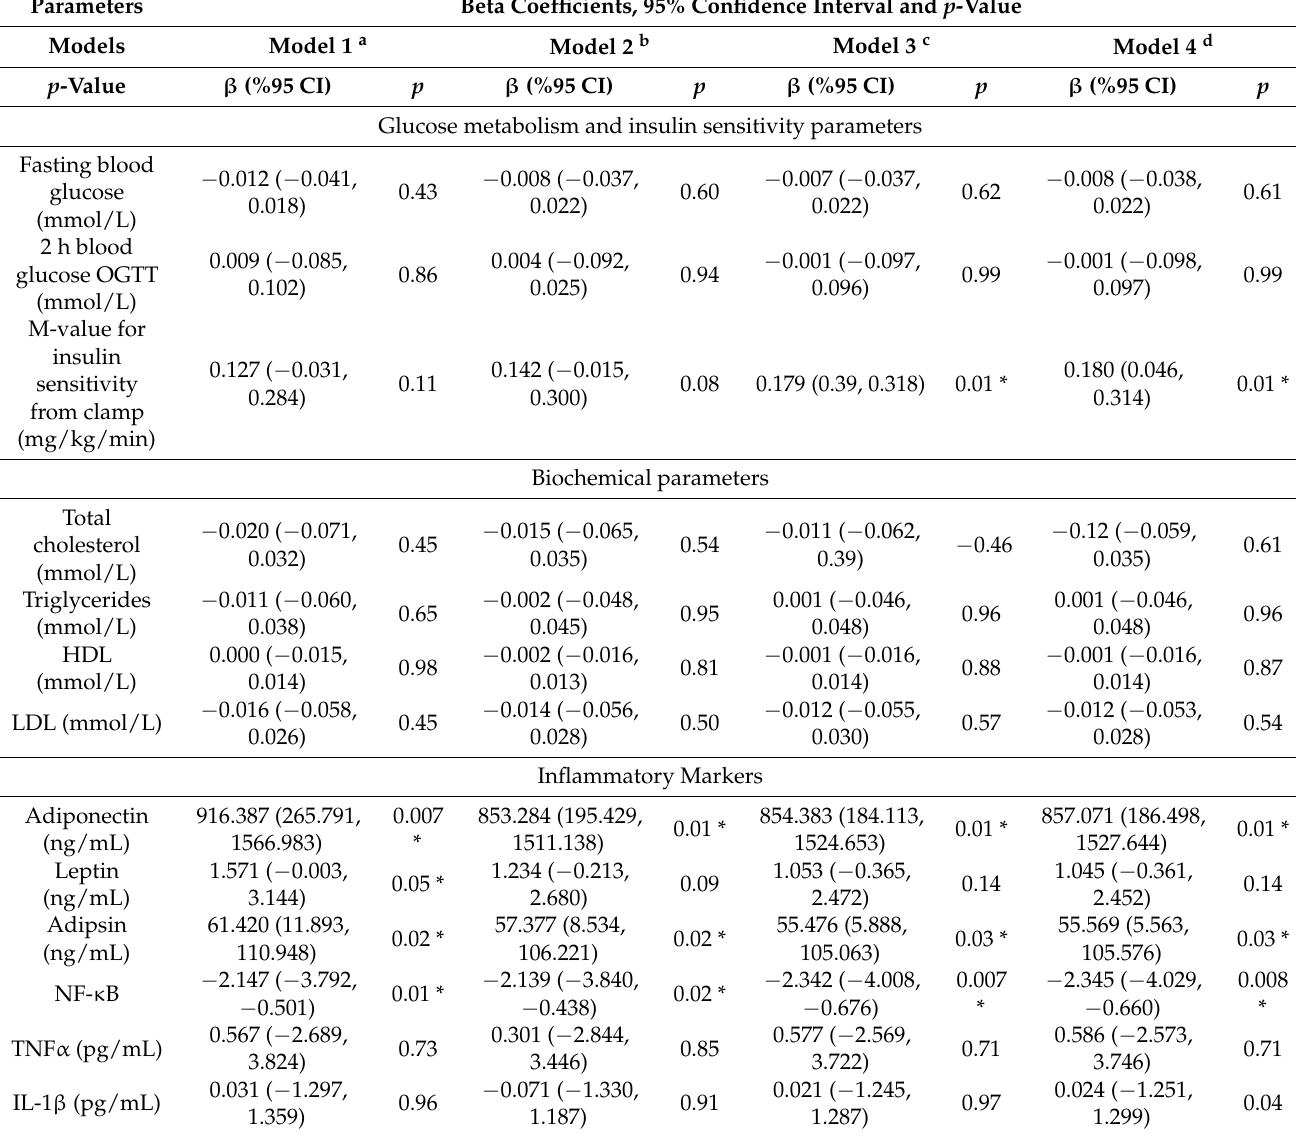
Table 2. Associations between Mediterranean Diet Score and anthropometry data, insulin resistance, and inflammatory markers ( n =